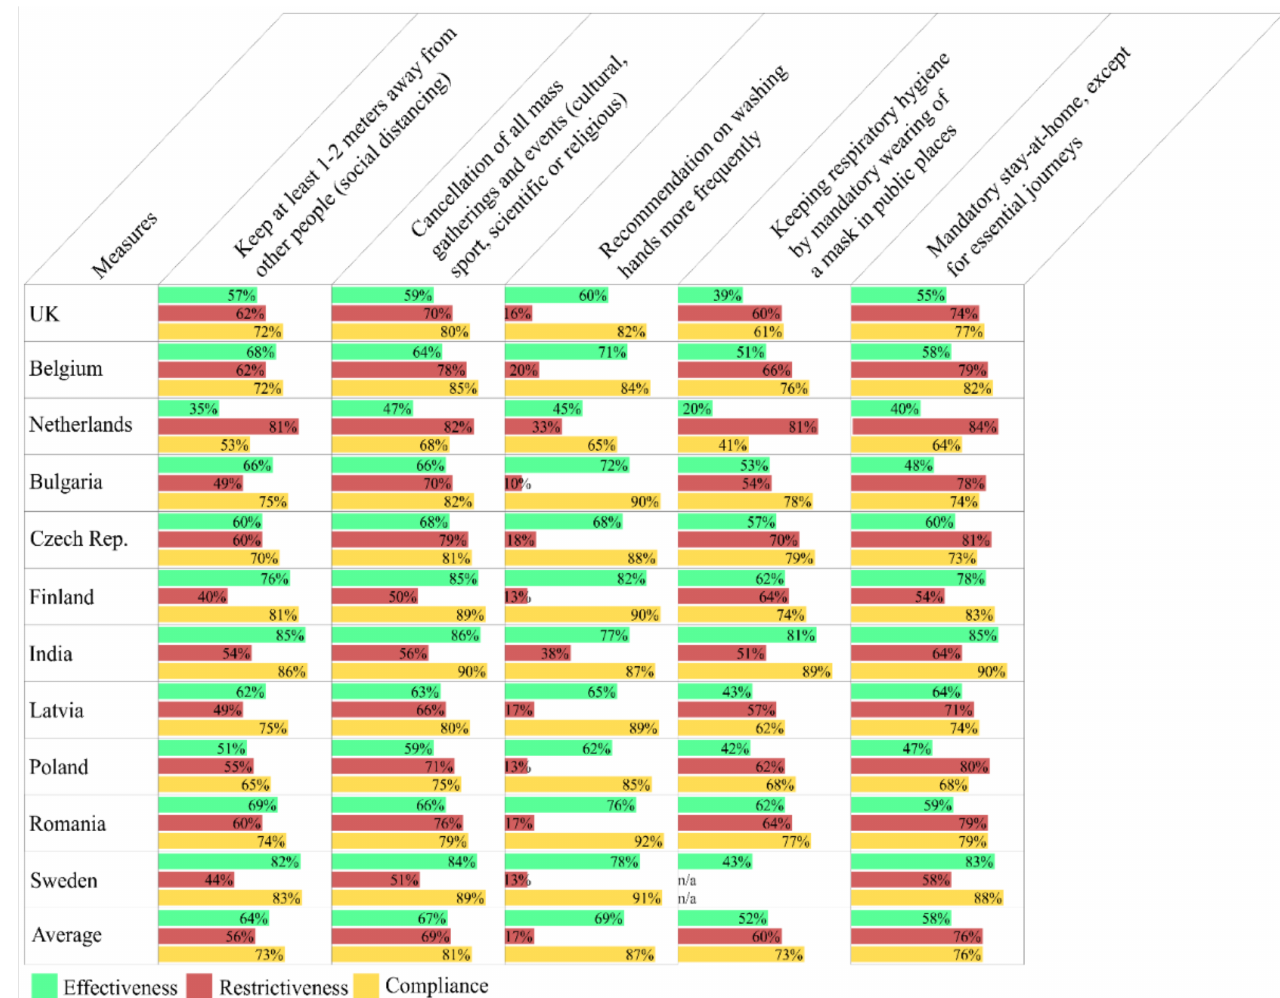
Figure 2. Perceived effectiveness, restrictiveness, and compliance per country for the five measures that have affected the highest number of people personally in all